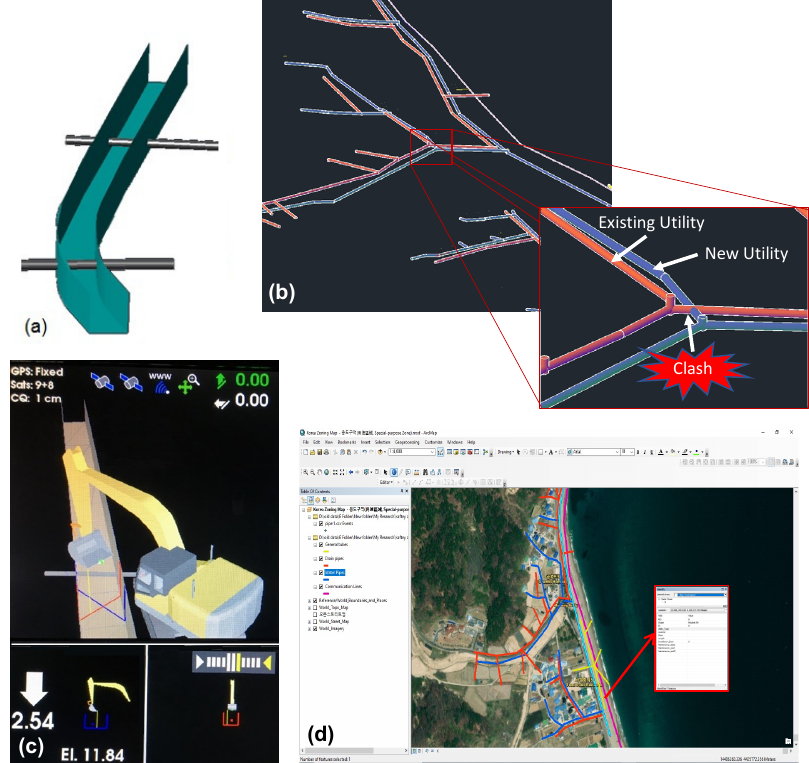
Figure 15. Application of developed BIM-GIS platform: ( a ) 3D excavation design drawing with existing underground utilities, ( b ) clash detection during design, ( c ) screenshot of machine guid- ance operator screen during excavation, ( d ) information retrieval from GIS database linked with a utility component.